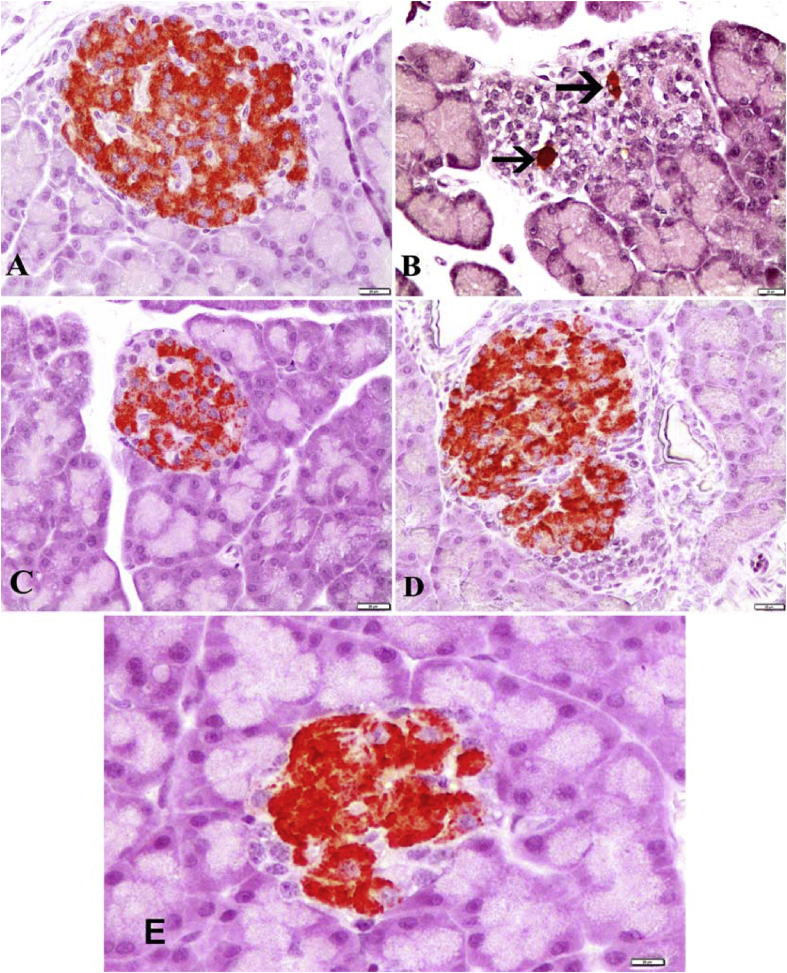
Immunohistochemical staining of islets of Langerhans of pancreas by streptavidin-peroxidase (ABC) method. A) Control group: Strong insulin immunoreactivity in β cells, which occupy most of the islet. B) Diabetic group: Weak insulin immunoreactivity in a few β cells (arrows). C) Diabetic + L. nobilis treated group: Moderate insulin immunoreactivity in β cells. D)L. nobilis group: Strong insülin immunoreactivity in β cells. E) Diabetic + Acarbose treated group: Moderate insulin immunoreactivity in β cells. Bar = 20 μm.